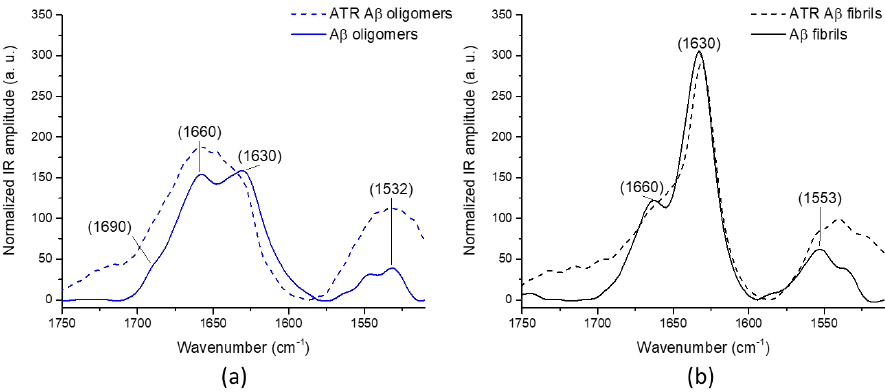
Figure 2. IR spectra of the oligomers and fibrils of A β species showed in Figure 1, normalized on the area of the amide I band. ( a ) The solid line corresponds to the averaged AFM-IR spectrum of 10 spectra recorded on di ff erent oligomers from Figure 1a and the dashed line is the spectrum obtained by ATR-FTIR ( b ) the solid line corresponds to the averaged AFM-IR spectrum of 25 di ff erent spectra recorded on di ff erent fibrils from Figure 1b, and the dashed line is the spectrum obtained by